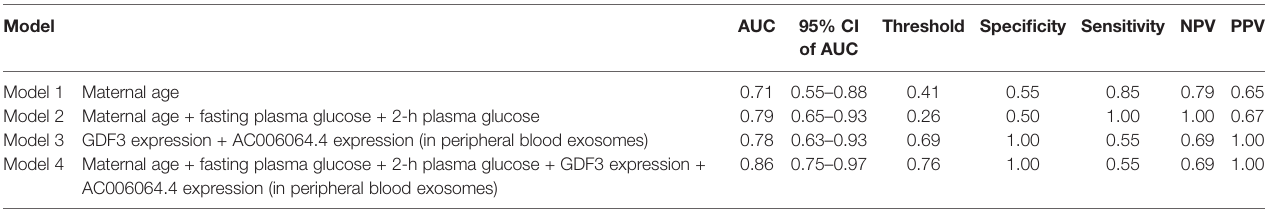
TABLE 2 | The discriminative ability of four panels between patients with GDM-M and controls.